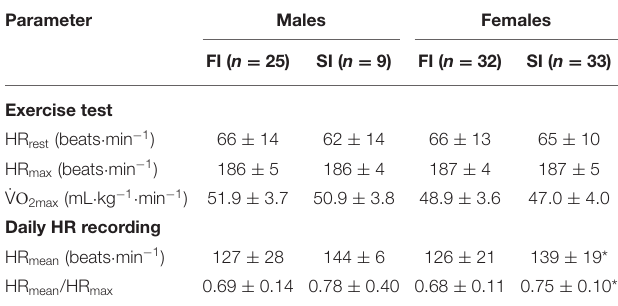
TABLE 2 | Physiological variables during maximal oxygen consumption ( ˙ V O 2max ) assessment and heart rate (HR) data during daily workload monitoring of fitness instructors (FI) and swimming instructors